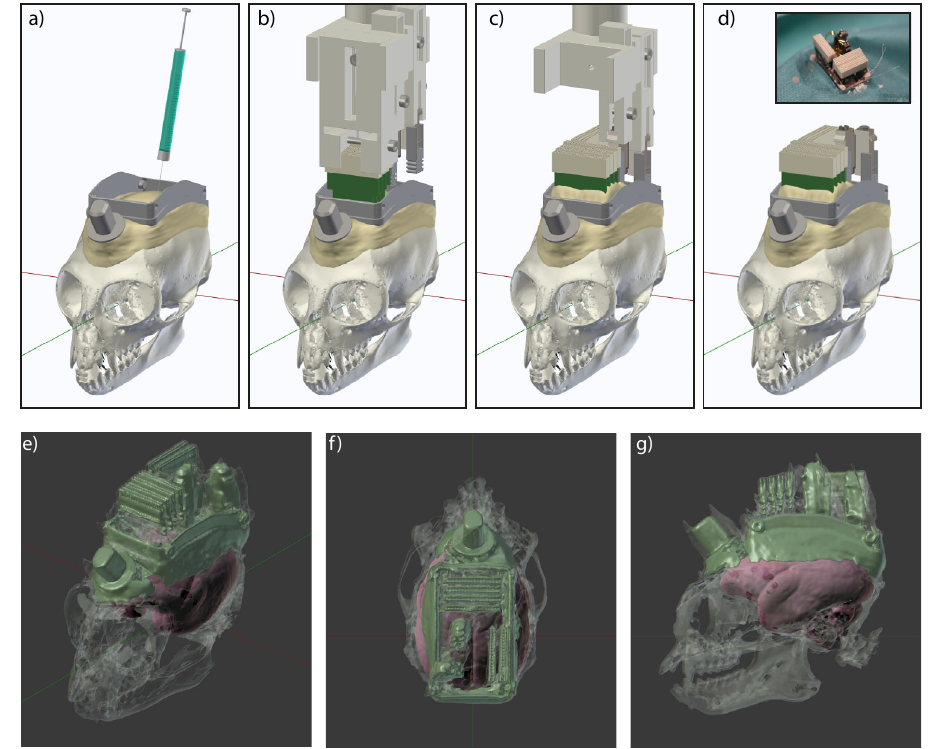
Fig. 4 | Surgery 2: Injection of the viral vector and implantation of silicon probes. a After stereotaxic alignment of the skull via the implantation holder and the chamber, a viral vector was injected into area V6. b A custom implantation holder,carryingconnectorPCBs,electrodes,andmicrodriveswasloweredintothe chamber. c First, the connector PCBs were cemented in place and the respective part of the holder was removed to ensure better access and visibility. Electrodes were then lowered sequentially into the two brain areas, and the respective